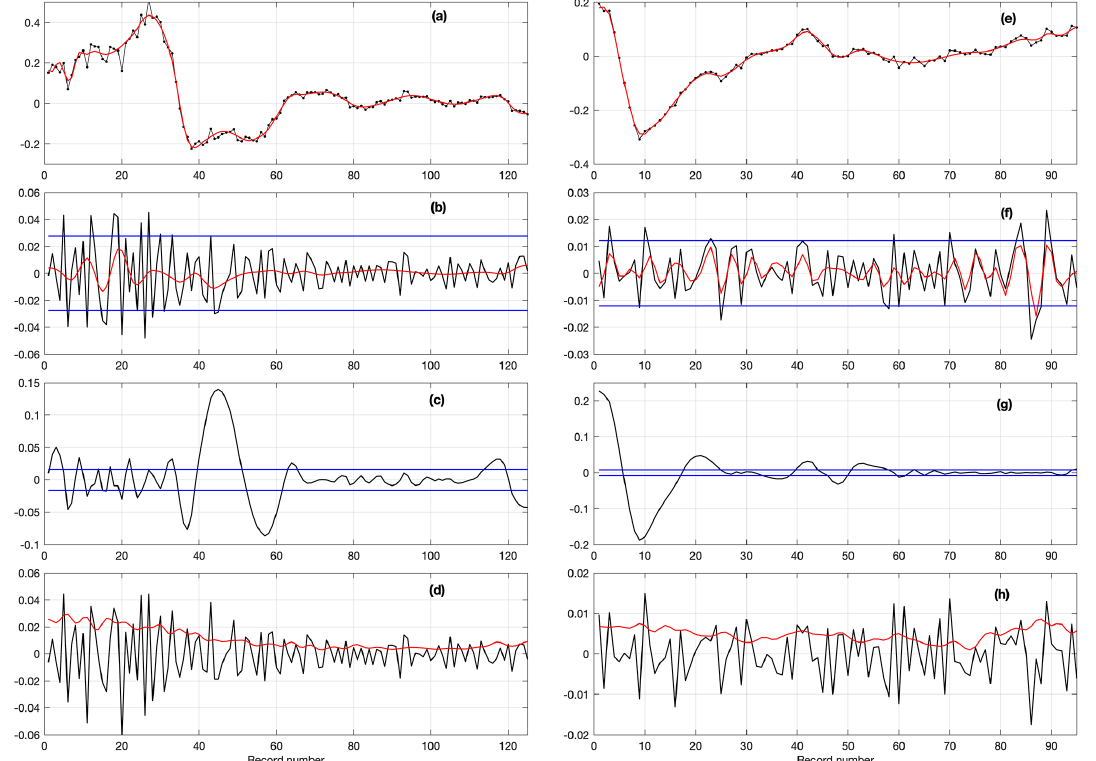
Figure 3. SARAL short data segments in the Gulf Stream area for cycle 106 and passes 53 (a–d) and 597 (e–h) . Panels (a) and (e) : noisy (black dotted) and denoised (red) SLA; panels (b) and (f) : IMF1 (black), useful signal (red) retrieved from wavelet denoising of IMF1, and thresholds (blue) to be applied in IMF1 EMD denoising; panels (c) ) and (g) : IMF2 (black) and thresholds (blue) to be applied in IMF2 EMD denoising; panels (d) and (h) : noise (black) retrieved from IMF1 wavelet denoising and uncertainty (red) attached to the denoised SLA. All units in meters on the y axis; x axis data are the record